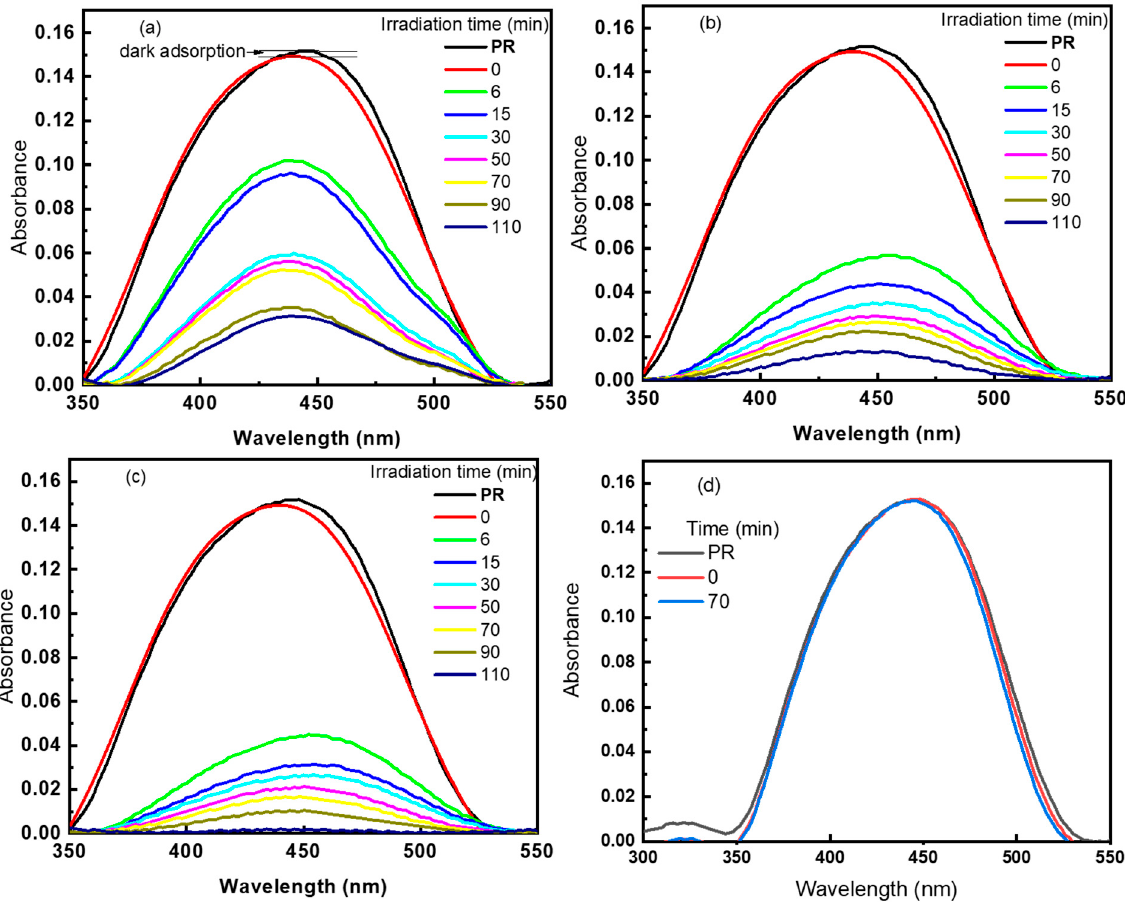
Figure 5. The photo absorbance spectra of phenol red in the presence of ( a ) TiO 2 , ( b ) TiO 2 /1 mg- KBrO 3 , ( c ) TiO 2 /5 mg-KBrO 3 , and ( d ) KBrO 3 samples.